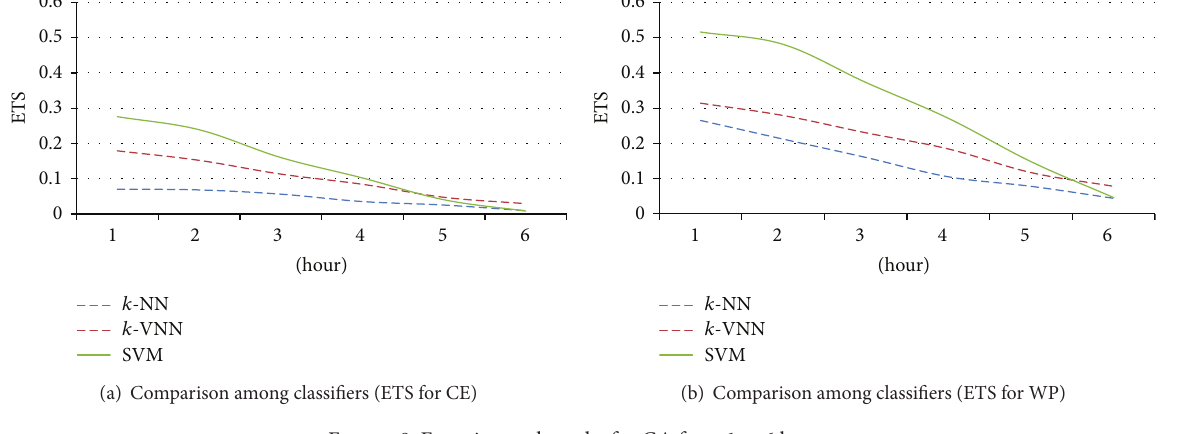
Figure 8: Experimental results for GA from 1 to 6 hours.